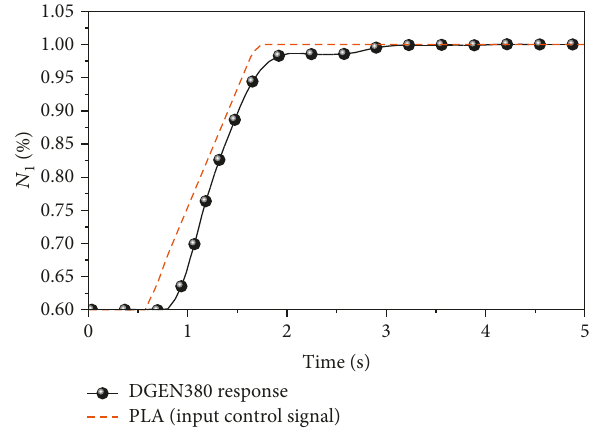
Figure 10: The test of single